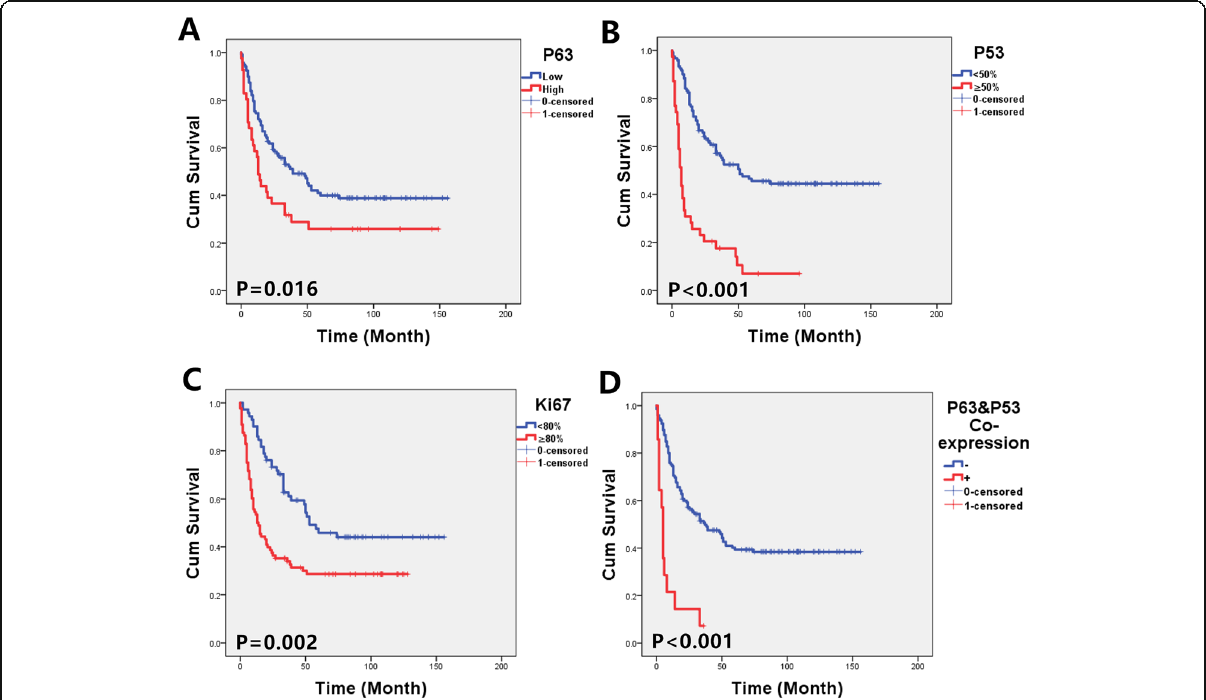
Fig. 4 OS curves in the subtypes of DLBCL. a Comparison of P63 high-expression (score ≥ 6) and low-expression (score<6) groups. b Comparison of P53 positive ( ≥ 50%) and negative (<50%) groups. c Comparison of Ki67 high expression ( ≥ 80%) and low expression (< 80%) groups. d P63 and P53 coexpression cases showed the worst prognosis